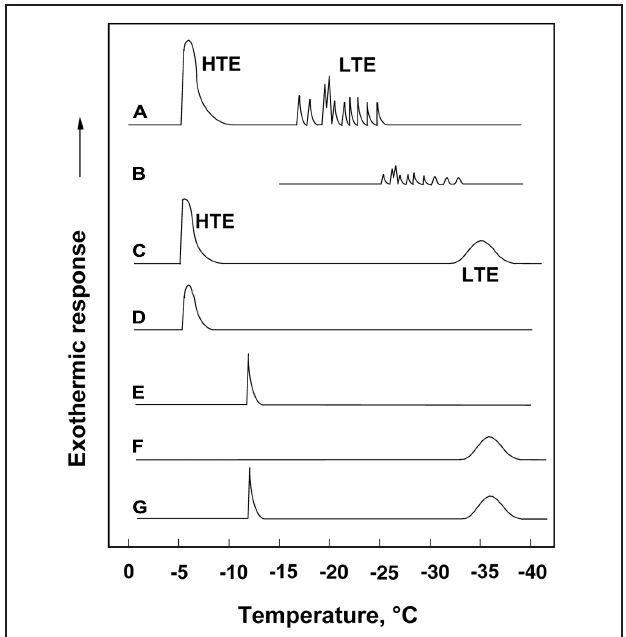
FIGURE 1 | (A) A typical DTA profile of an Rhododendron japonicum flower bud with 1 cm twig (collected in early December) cooled at 3 ◦ C/h, showing a HTE at − 5 ◦ C and spike-like LTEs between − 17 and − 24 ◦ C, which got smaller and shifted to lower temperatures when the flower bud was stored at − 15 ◦ C for 3 days before being used for DTA without thawing (B) . A typical DTA profile of an intact current year 2.5 cm stem (C) , excised bark (D) , excised xylem showing a single exotherm peak at